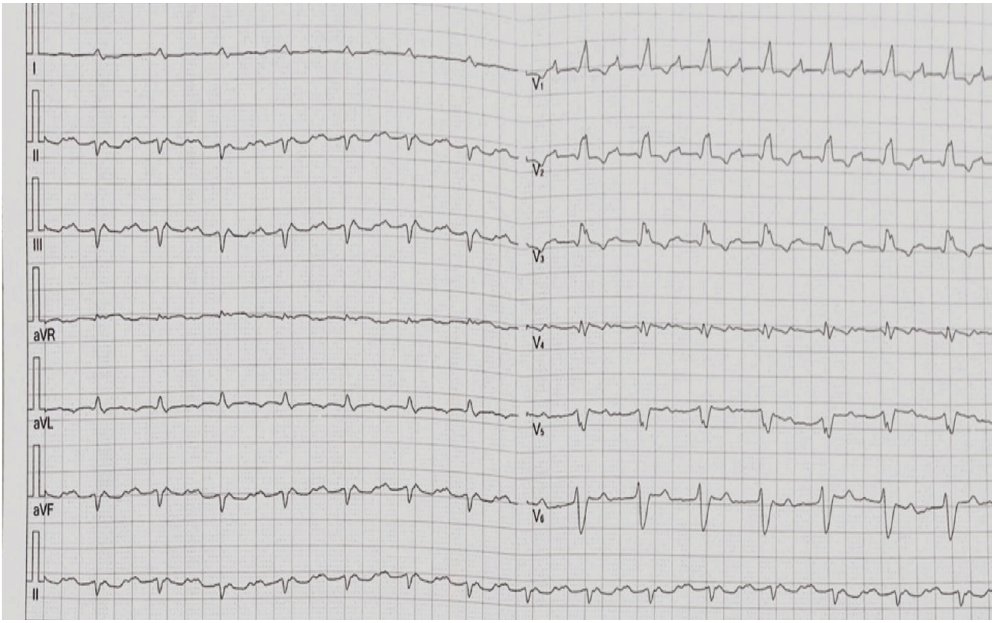
Figure 2: ECG at